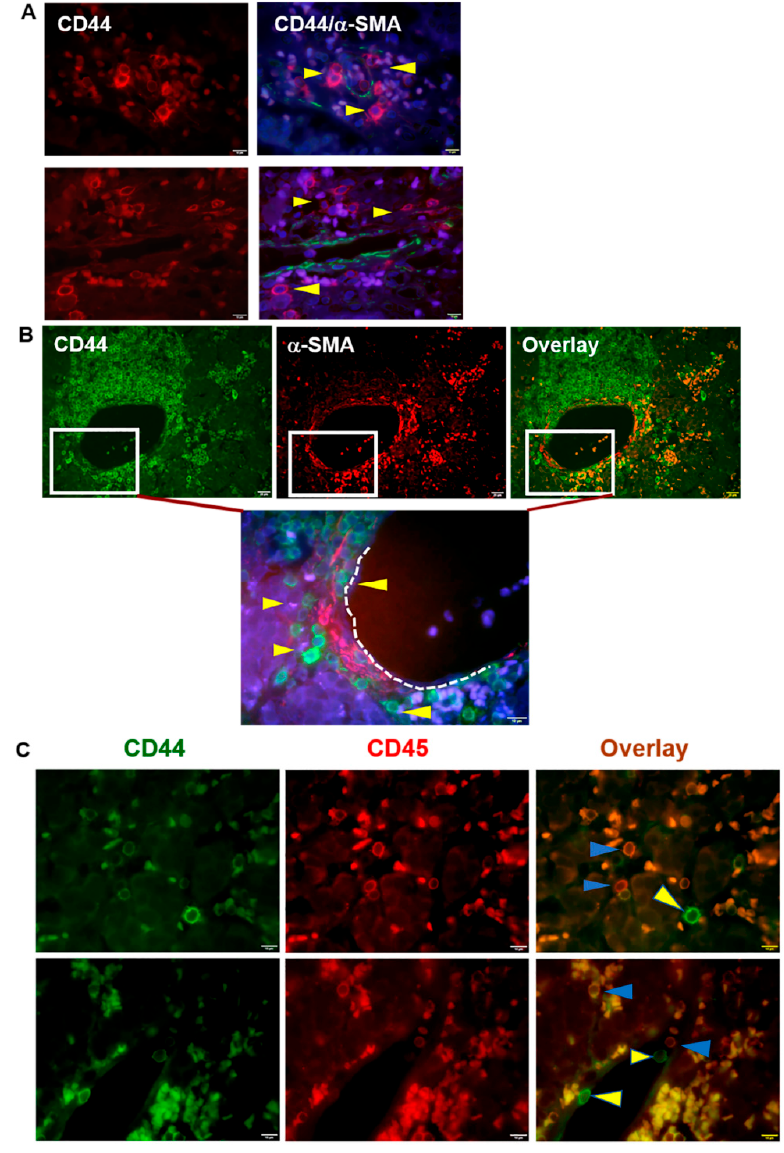
Figure 1. Identification and distribution of CD44-positive cancer stem-like cells in human pNET tissues. ( A ) Human pNET specimens in patient 1 were co-stained with CD44 and α -SMA antibodies, followed by appropriate secondary antibodies, with DAPI staining the nuclei (blue). Images were acquired by immunofluorescence microscopy. CD44-positive cancer cells (red) marked by yellow arrowheads were close to the α -SMA positive (green) blood vessels. ( B ) Human pNET specimens in patient 2 were co-stained as in ( A ). CD44-positive cancer cells (green) were indicated by yellow arrowheads, which were close to the α -SMA positive (red) blood vessels. A subset of CD44-positive cells appeared to be distributed within the α -SMA-positive vascular niche or nearby blood vessels. Shown are representative images from individual patients. Bar = 10 or 20 µm. ( C ) Human pNET tissues were co-stained with CD44 antibodies and CD45 antibodies followed by appropriate secondary antibodies. Overlay images were collected by immunofluorescence microscopy. CD44-positive (green, yellow arrowheads) and both CD44-positive and CD45-positive cells (orange, blue arrowheads) were observed under a fluorescence microscope. Images were acquired by an Olympus BX60 fluorescence microscope equipped with a CCD camera. Shown are representative images from two individual patients. Bar = 10 µm. Cells positive with both CD44 and CD45 are smaller in size and nucleus, and regarded as lymphatic cells (orange), a subset of cancer cells, which are bigger and positive for CD44 but negative for CD45, suggesting their stem cell-like phenotype.